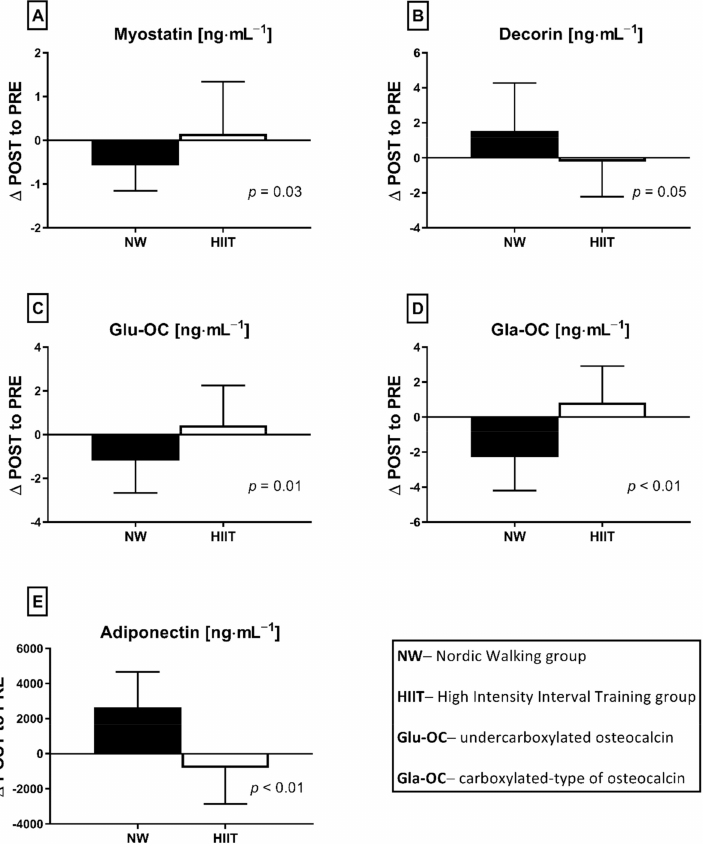
Figure 5. The differences between NW ( n = 18) and HIIT ( n = 14) training programs expressed as delta changes ( ∆ POST to PRE) in myokines ( A , B , E ) and osteokines ( C , D ) concentration, before and after applied interventions. Values are statistically significant. Analysis of variance (rANOVA) was